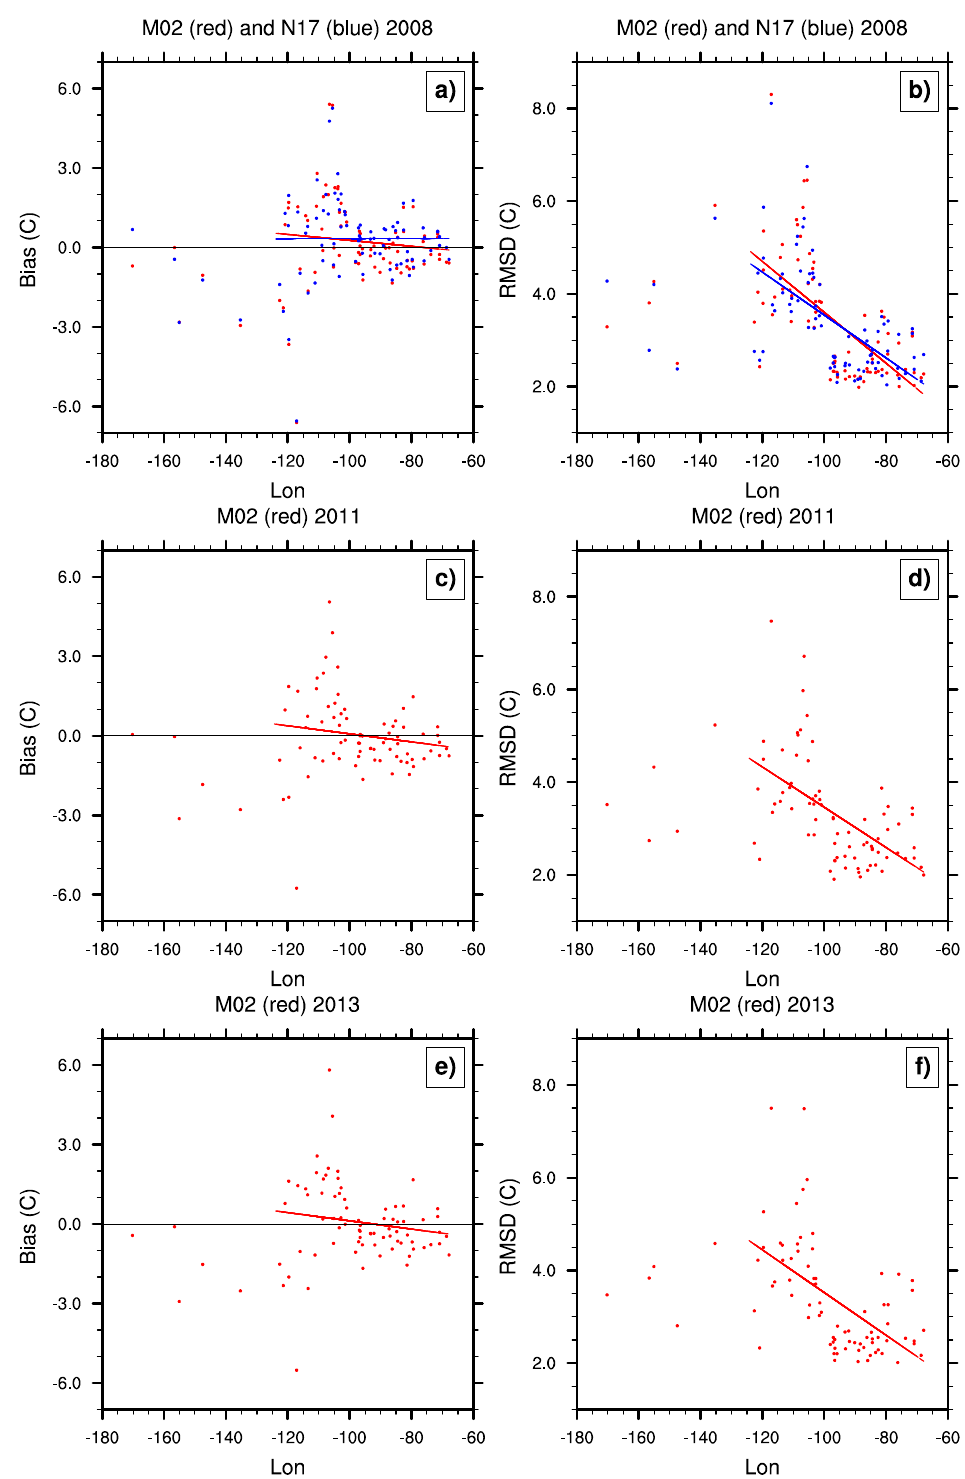
Figure 6. Scatter plots of annual mean bias and RMSD (°C) of HIRS SAT co-located to each USCRN station along longitude for 2008, 2011, and 2013. The bias and RMSD values for the three years are plotted in ( a ) and ( b ) for 2008, in ( c ) and ( d ) for 2011; and in ( e ) and ( f ) for 2013, respectively. Lines represent the least squares fit to the data. N17 data are in blue and M02 data are in red.